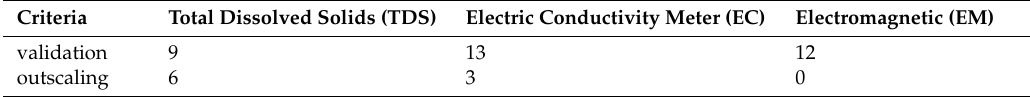
Table 4. Comparison of criteria categorized into validation and outscaling dimensions.